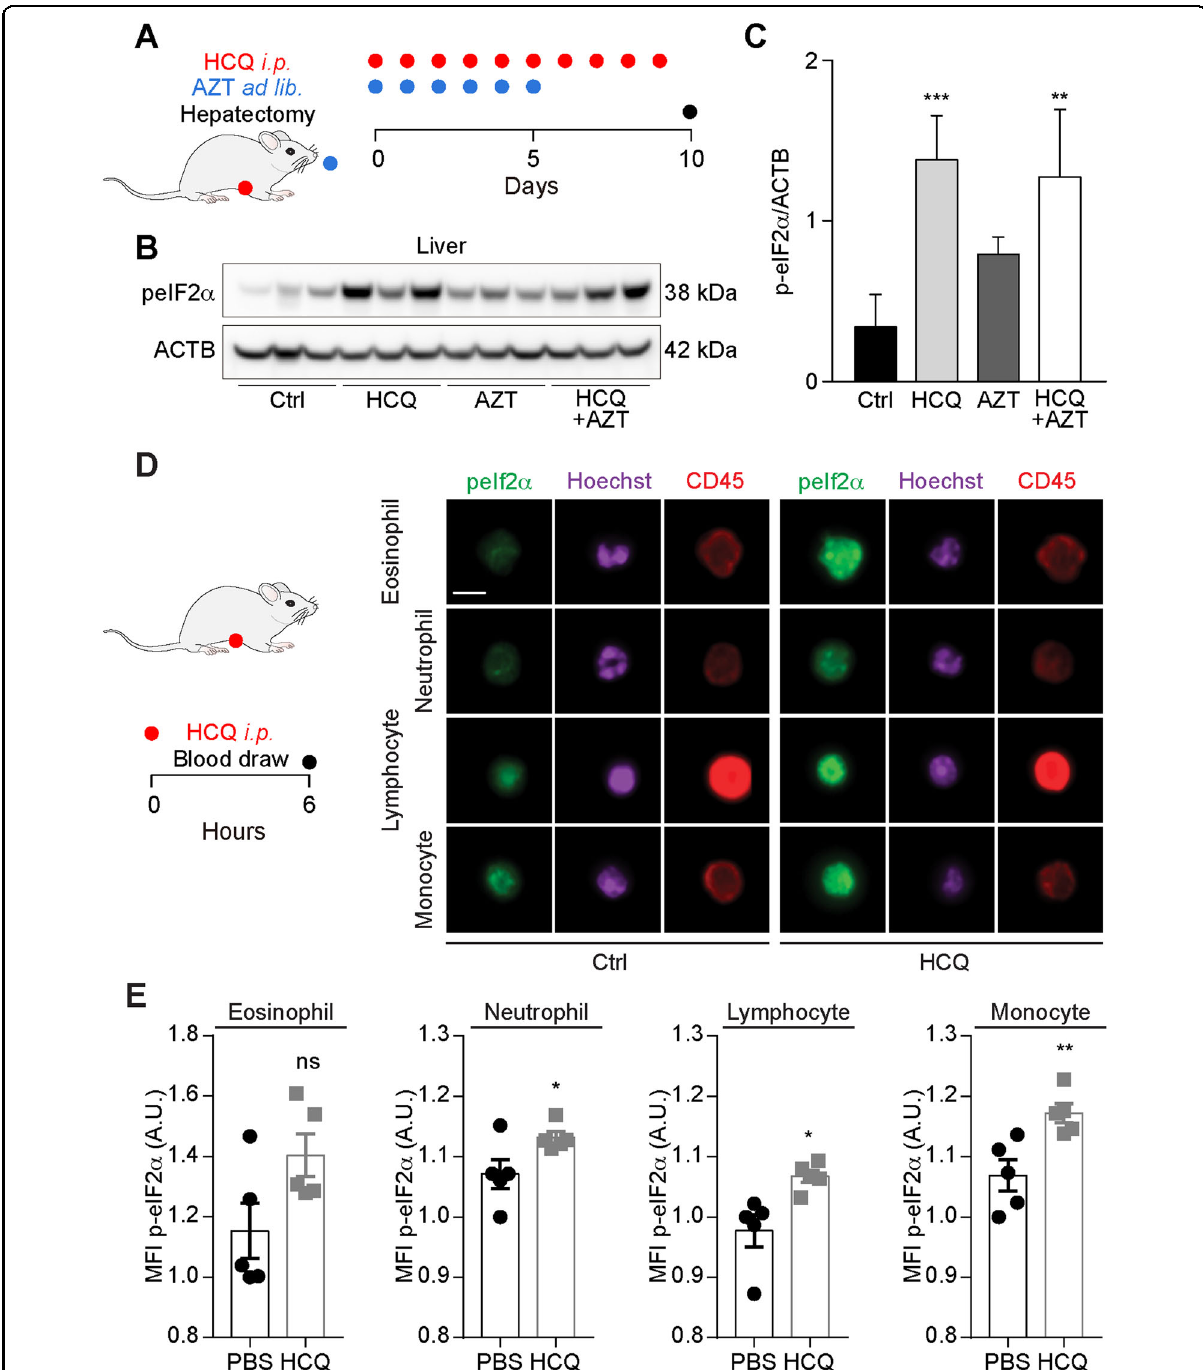
Fig. 6 Effects of hydroxychloroquine plus azithromycin in vivo. Mice were treated intraperitoneally (i.p.) with 50 mg/kg/day hydroxychloroquine (HCQ), orally fed with azithromycin (AZT) (3 mg/L in drinking water), or their combination as illustrated in the scheme ( A ). Livers were excised from three mice by group at the end of the treatment and the tissues were subjected to protein extraction for SDS – PAGE and immunoblot to detect the phosphorylation of peIF2 α ( B ). β -Actin (ACTB) was used as a loading control. Band intensities were quanti fi ed by densitometry and the ratio of peIF2 α to ACTB was calculated. Data are expressed as means ± SEM of three mice ( C ). Statistical signi fi cance is indicated as ** P < 0.01 and *** P < 0.001 as compared with untreated control (Ctrl) (Student ’ s t -test). D, E Mice were treated with 50 mg/kg HCQ i.p. and blood was collected after 6 h to determine the level of peIF2 α by immuno fl uorescence and image fl ow cytometry in the depicted leukocyte populations. Representative images are shown in D . The scale bar equals 10 μ m. Data are expressed as mean fl uorescens intensities (MFI) means ± SEM of fi ve mice ( E ). Statistical comparisons were done by two-tailed unpaired Student ’ s t -test ( E ) comparing HCQ-treated to control mice that received PBS (* P < 0.05, ** P < 0.01).